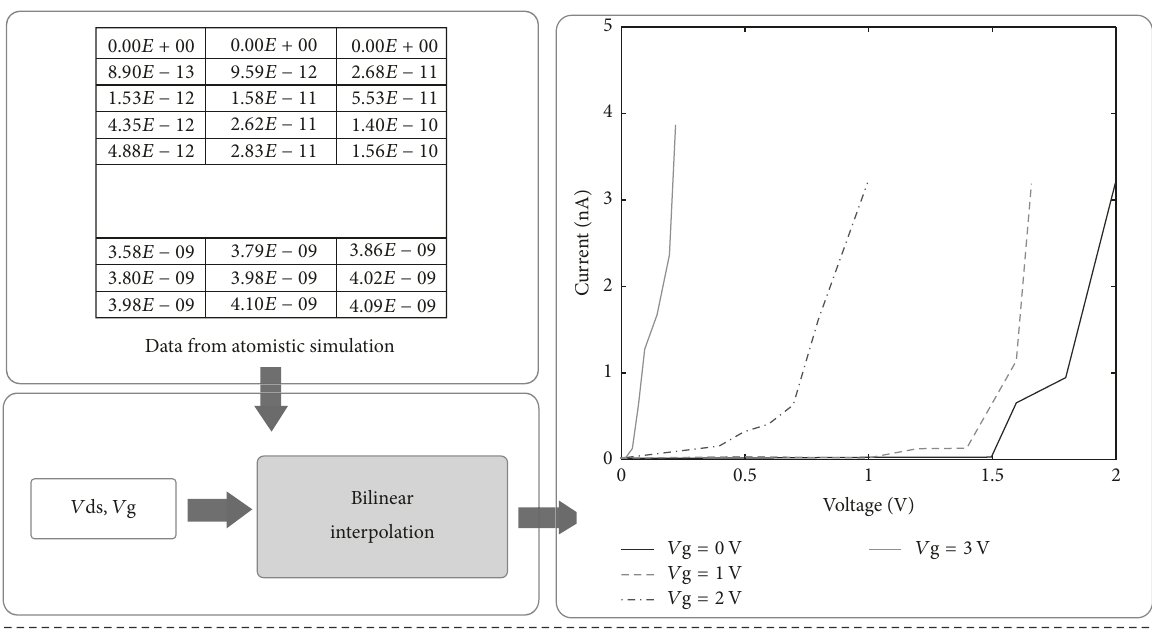
Figure 5: Semiempirical look-up table (SE-LUT): results obtained from ATK simulations for specific bias points ( 𝑉 g, 𝑉 ds) organized in tabular form; at the intermediate bias points current is obtained by bilinear